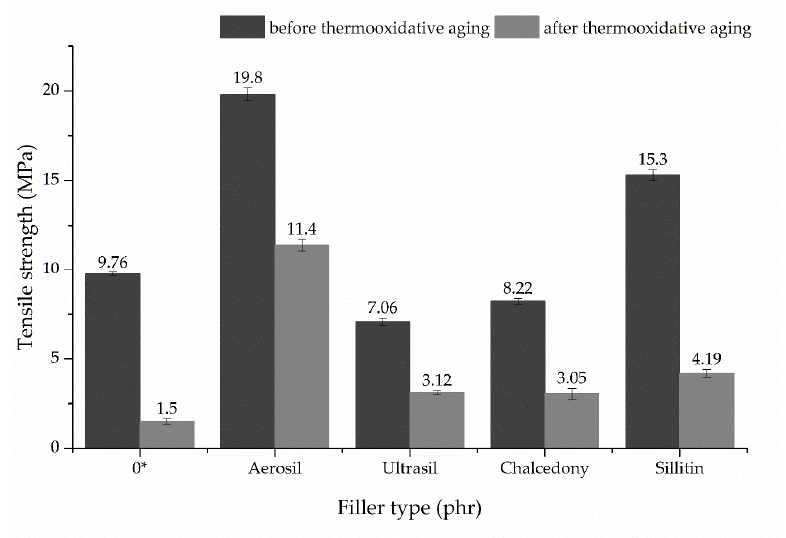
Figure 6. Mechanical properties of unfilled and filled CR/BR/nano-Fe 2 O 3 vulcanizates, before and after thermooxidative aging.